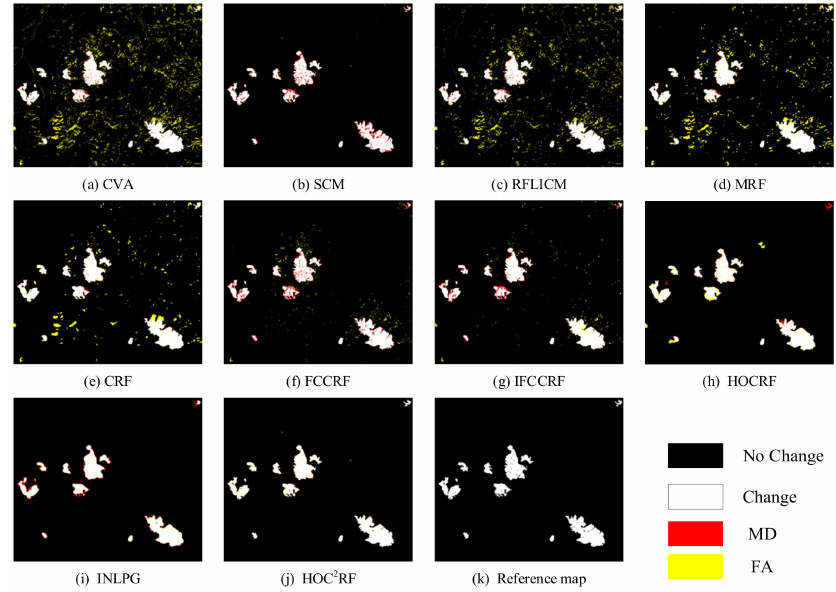
Figure 6. CD maps produced by different methods for the Neimeng dataset. Table 3. Quantitative indicators for CD maps on the Neimeng